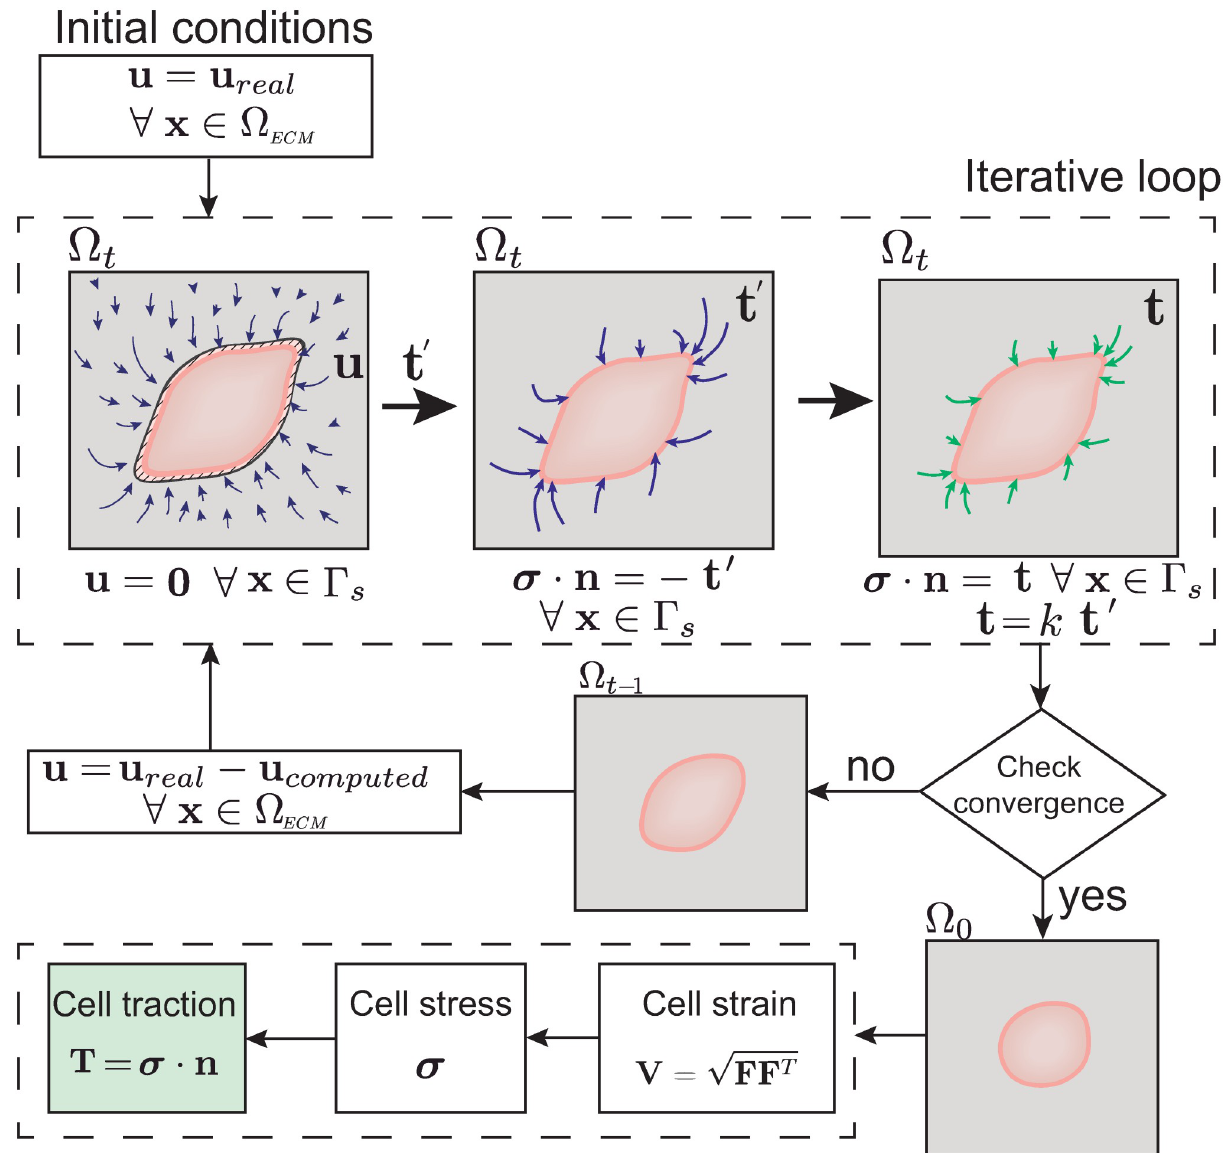
Fig 2. Scheme of the iterative workflow. During the iterative loop, three different analyses are run to solve the inverse problem. In the first analysis, the displacement field ( u ) is applied, and the surface ( Γ s ) is encastered. Thus, a set of intermediate reaction forces ( t 0 ) is obtained. The intermediate reaction force field obtained is applied in the opposite direction. This results in an estimated displacement field ( u 0 ). The ratio between u and u 0 is used to adjust the previous traction force field to a new one ( t ), resulting in a new deformed configuration. This process is repeated until convergence is achieved. To extract the cell surface traction field, the logarithmic strains are